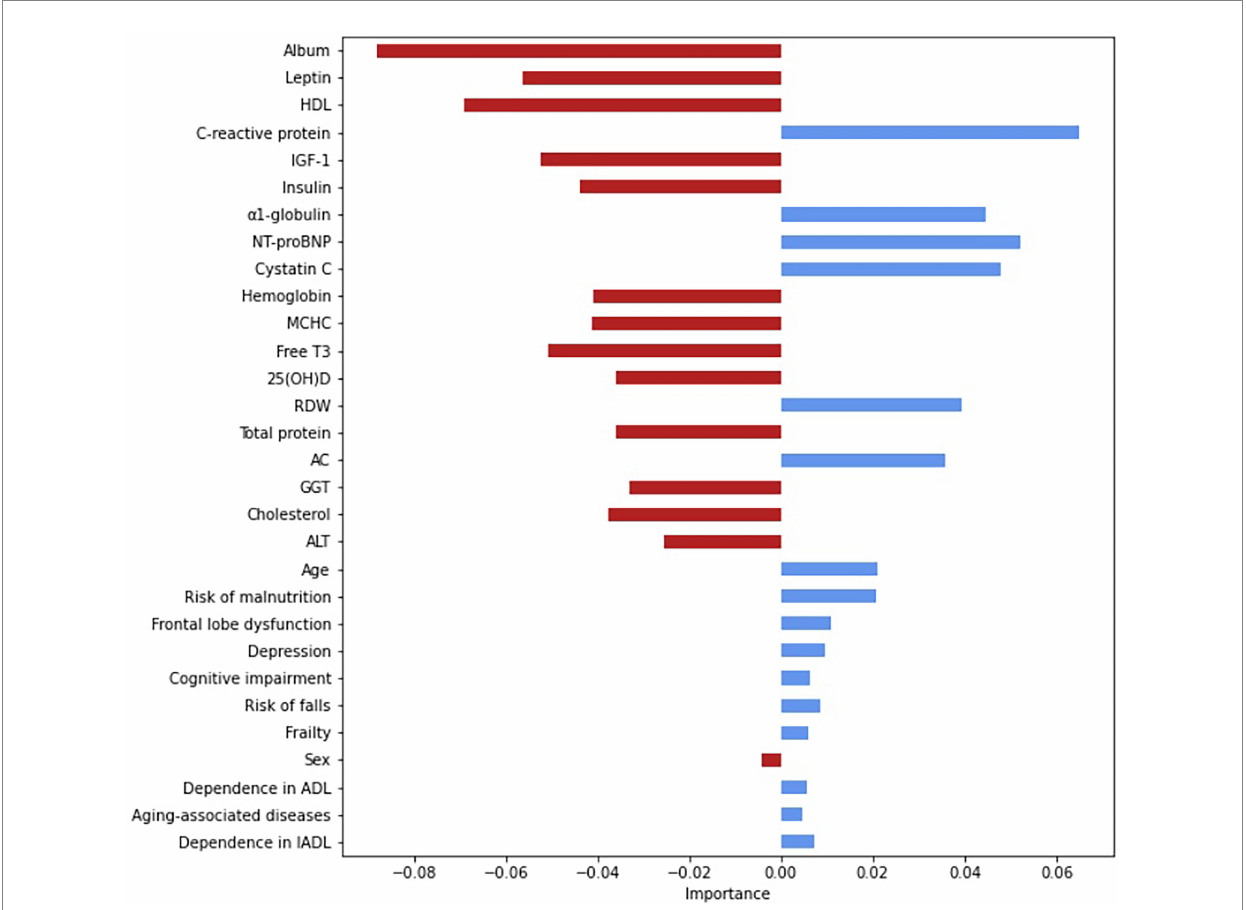
FIGURE 2 Assessment of the relative importance of the input variables, based on the Gini coefficient. The Gini coefficients are absolute values. The relative importance is indicated by the deviation from point zero (the Gini coefficient); the direction and color of the bars show the effect on the risk of all- cause mortality: the red indicates a lowering risk with an increasing coefficient; the blue—an increasing risk with an increasing coefficient. AC, atherogenic coefficient; ADL, activity of daily-living; ALT, alanine transaminase; free T3, free triiodothyronine; GGT, gamma-glutamyl transferase; HDL, high-density lipoprotein cholesterol; IADL, instrumental activity of daily-living; IGF-1, insulin-like growth factor 1; MCHC, mean corpuscular hemoglobin concentration; NT-proBNP, N-terminal pro b-type natriuretic peptide; RDW, red cell distribution